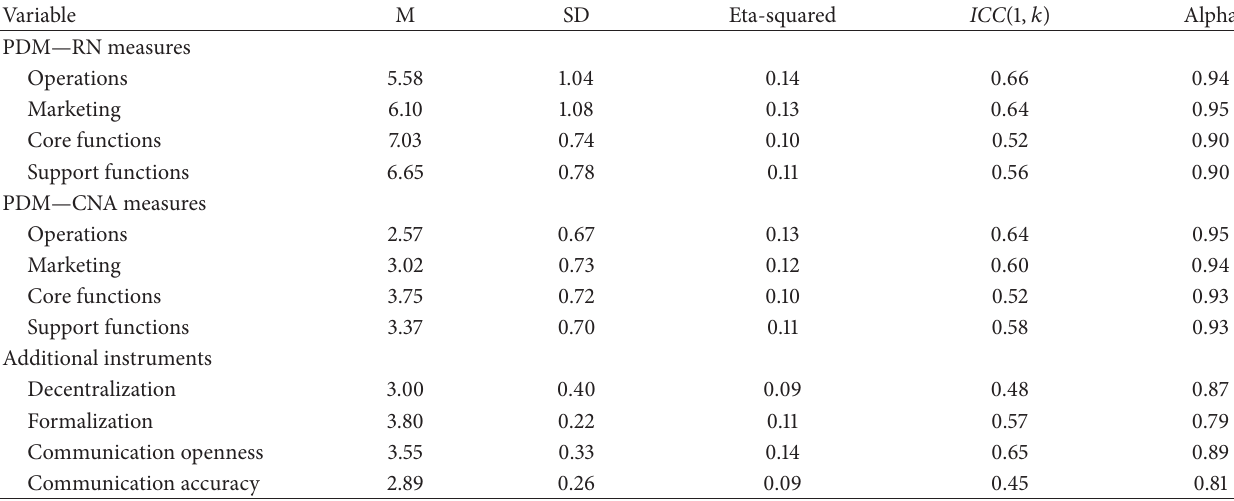
Table 2: Study II: Organization means, standard deviations, and reliabilities of total PDM scores ( 𝑁 = 195